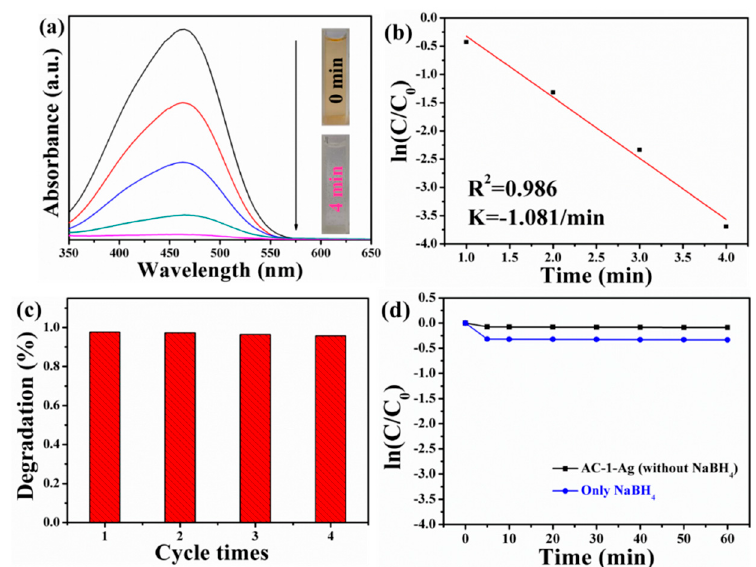
Figure 8. Time-dependent UV–Vis absorption spectra ( a ) and corresponding pseudo-first-order kinetic reaction plots ( b ) for reduction of MO catalyzed by AC-1-Ag NCs. Reusability of AC-1-Ag NCs for catalytic reduction of MO ( c ). Time-dependent degradation efficiency of MO solution catalyzed by AC-1-Ag NCs in different catalytic reaction conditions ( d ).